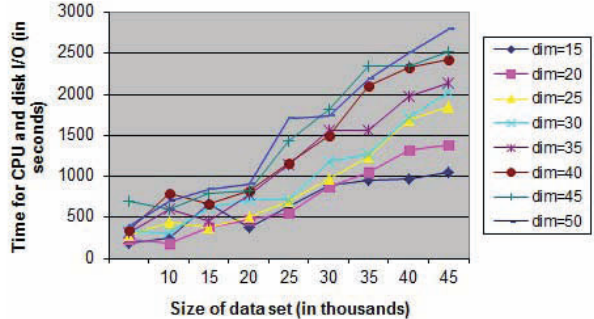
Figure 2. Running time on data sets with increasing data set